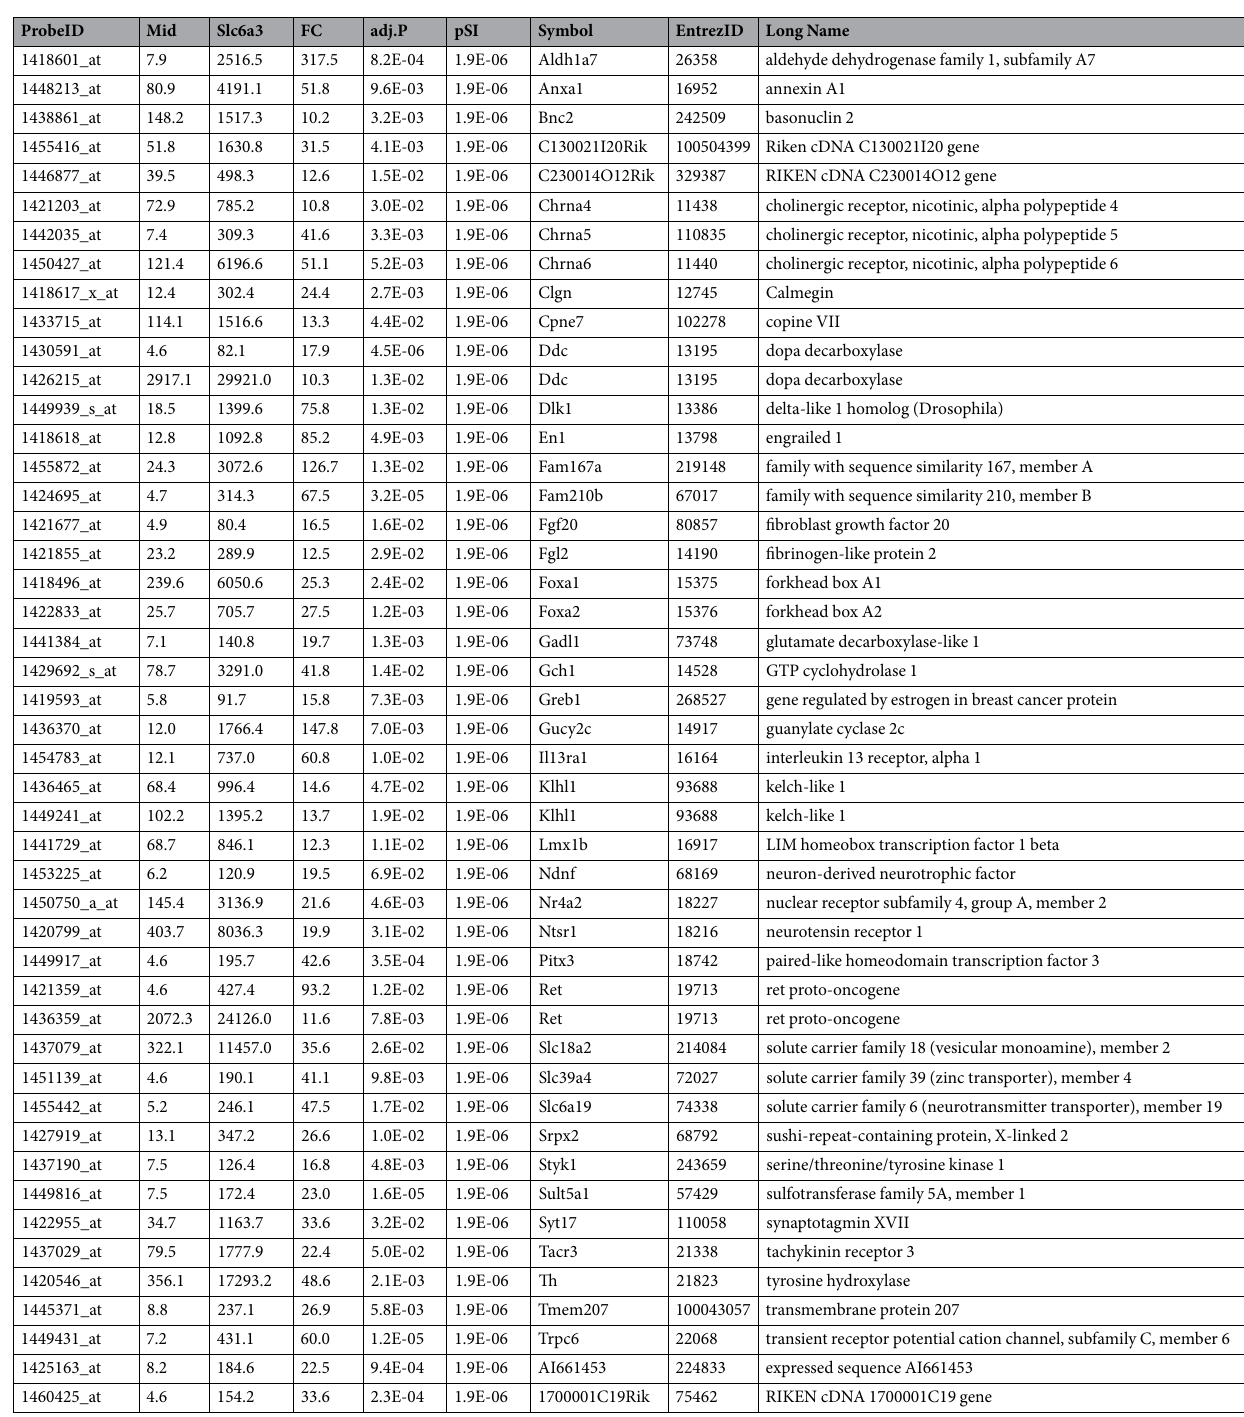
Table 1. Probesets with > 10 fold enrichment, p < 0.01, and pSI < 0.10e-6. ProbeID : Affymetrix Probe ID, Mid , Slc6a3: Expression level in midbrain Input RNA and Slc6a3 TRAP RNA, respectively. FC: ‘Fold-Change’ value of Slc6a3/Mid. adj . P: LIMMA FDR adjusted p-value for Slc6a3 vs Mid. pSI : Specificity index statistic p-value, when Slc6a3 is compared to other TRAP samples (Fig. 2C). Symbol : Official gene symbol. EntrezID: Entrez Gene ID. Long Name: Official gene